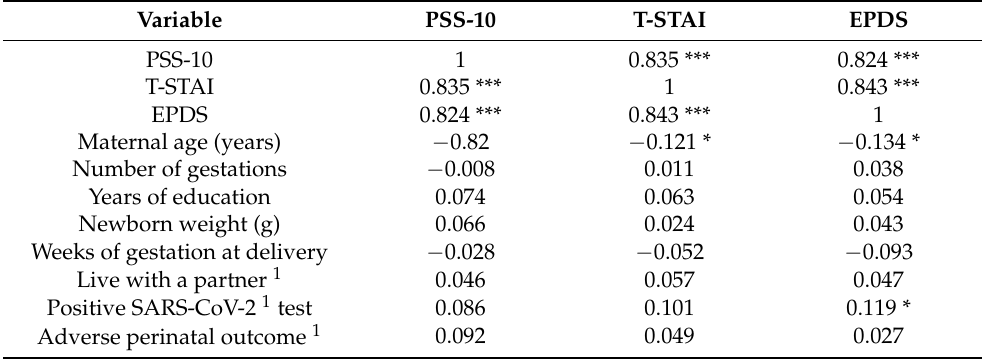
Table 4. Correlation between the total PSS-10 score with the total EPDS and T-STAI scores and the sociodemographic